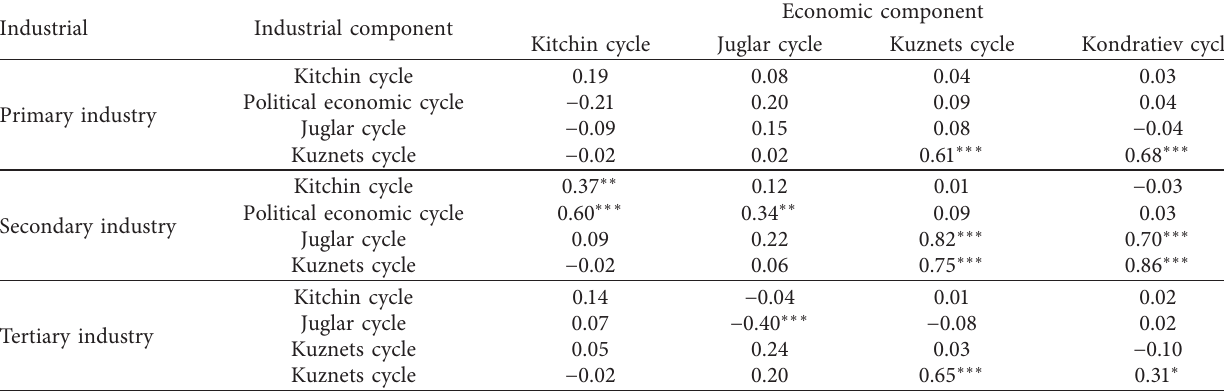
Table 3: Correlation between industrial and the economic cycle components of Heilongjiang Province.